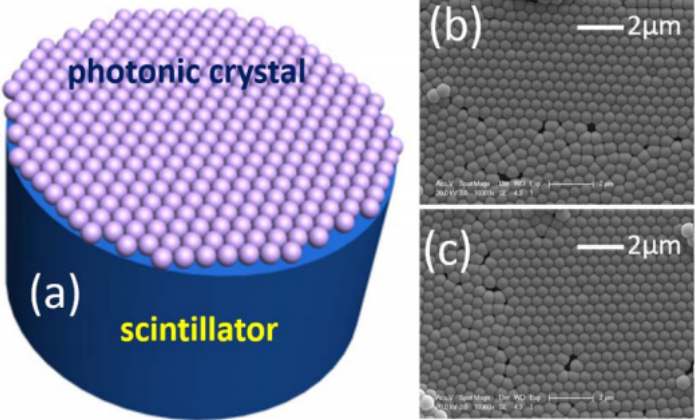
Figure 17. PhCs produced with self-assembly of polystyrene nanospheres and a deposited conformal layer of TiO 2 . ( a ) Schematic illustration of the photonic crystal structures covered on the surface of scintillator. ( b , c ) SEM images of photonic crystal structures on the surface of LYSO Scintillators A and B, respectively